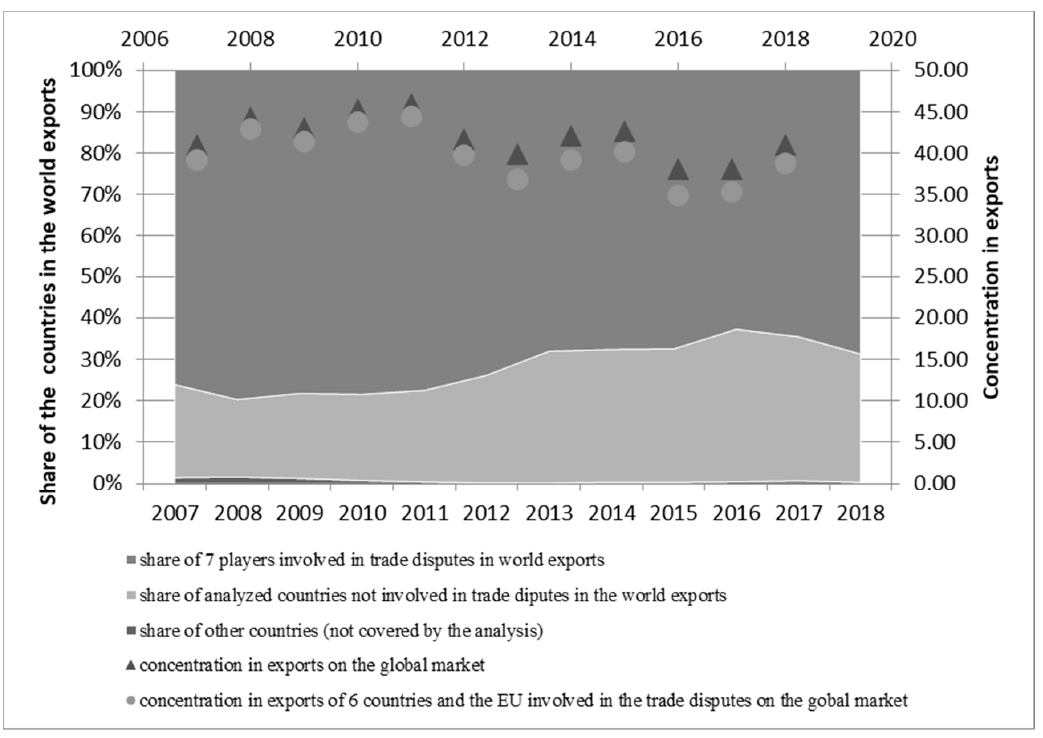
Figure 2. Share of analyzed countries in total exports and concentration of world’s photovoltaic panels exports in 2007–2018. Source: own elaboration based on the ITC Trade Map